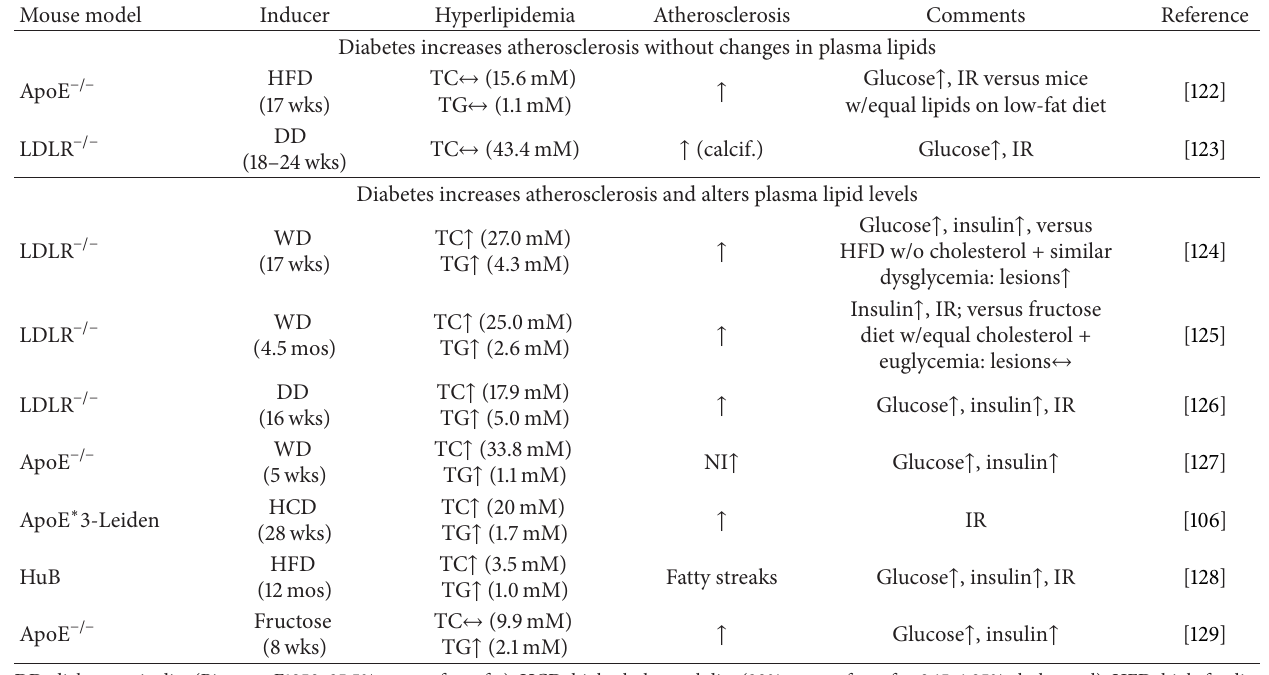
Table 2: Atherosclerotic mouse models with increased atherosclerosis after diet-induced diabetes. Mouse